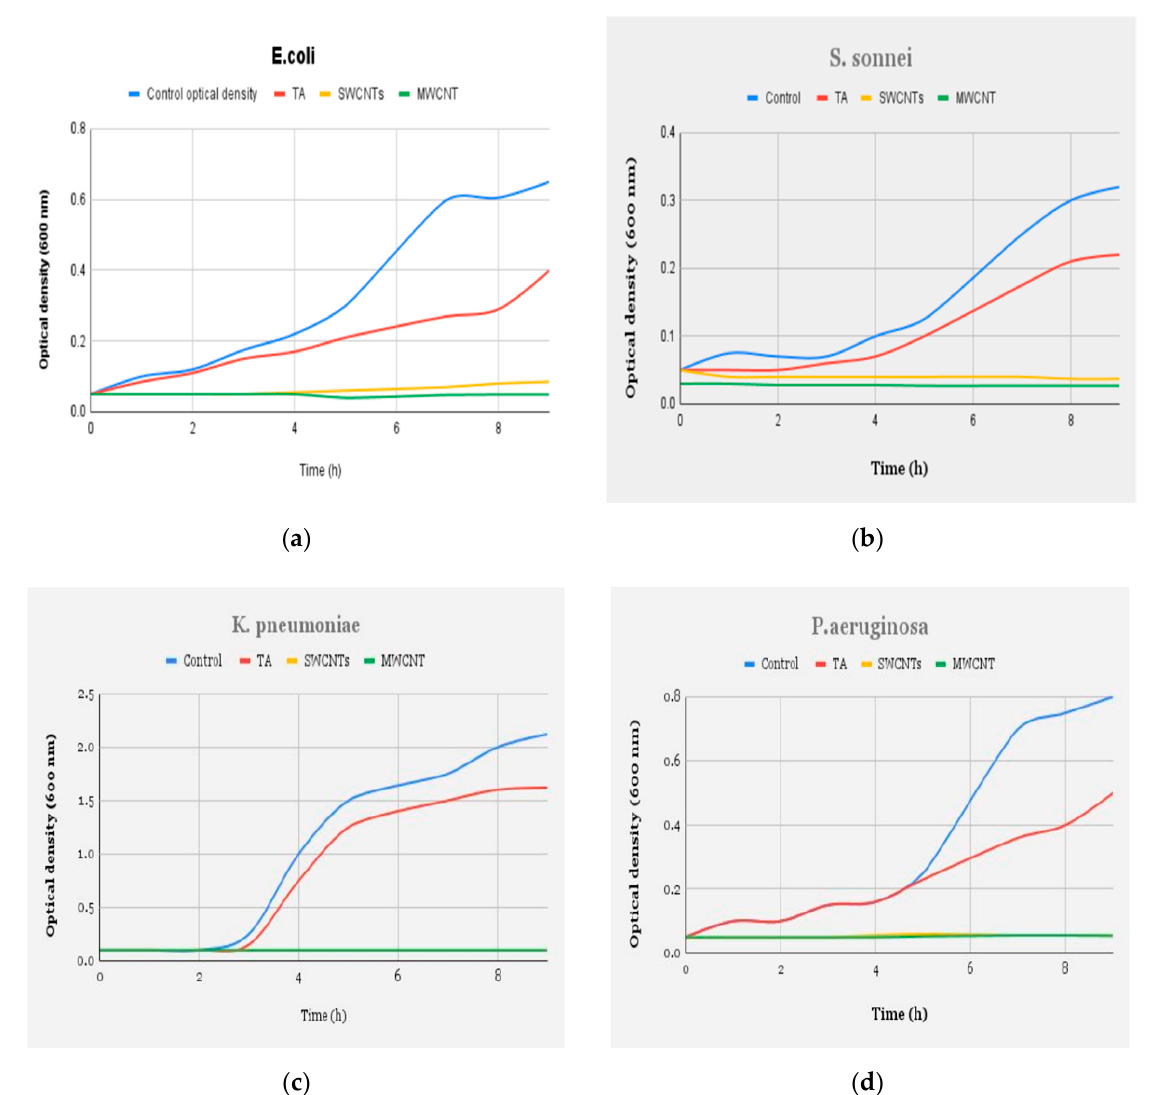
Figure 5. Growth curve measurements of ( a ) E. coli , ( b ) S. sonnei , ( c ) K. pneumoniae, and ( d ) P. aeru- ginosa in minimal broth showing antibacterial effects of SWCNTs/MWCNTs (90 μ g/mL) and their amelioration on the antioxidant (TA)-coated CNTs (90 μ g/mL) as compared with the control sample. The cell density of various bacterial species used in the treatments ranged between 1 and 1.6 × 10 7 CFU/mL (Reproduced with permission from ACS Publications; adapted from Rajavel et al, 2014 [46)].